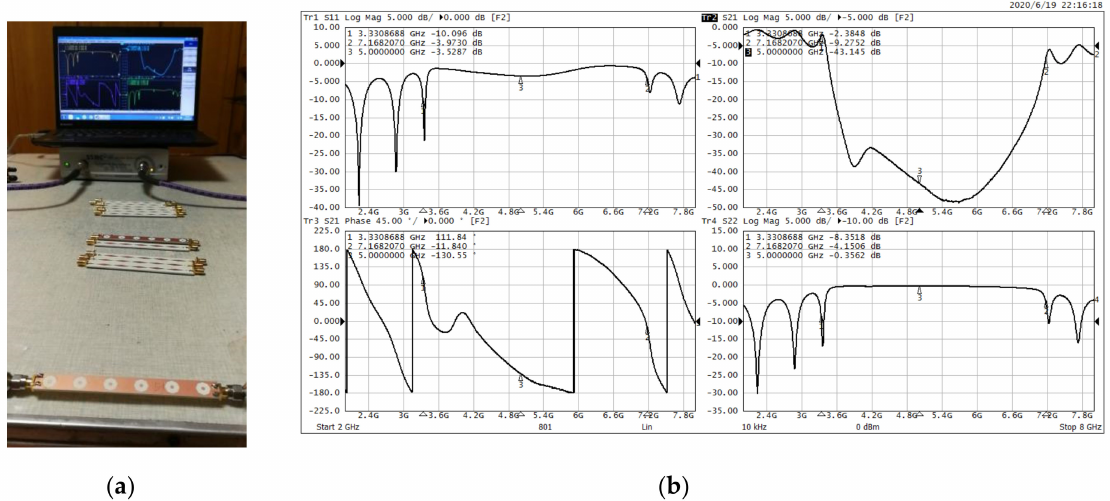
Figure 16. ( a ) Physical test photos of the band stop filter etched periodic octagonal ring EBGs; ( b ) physical measurement results of the band stop filter etched periodic octagonal ring EBGs.